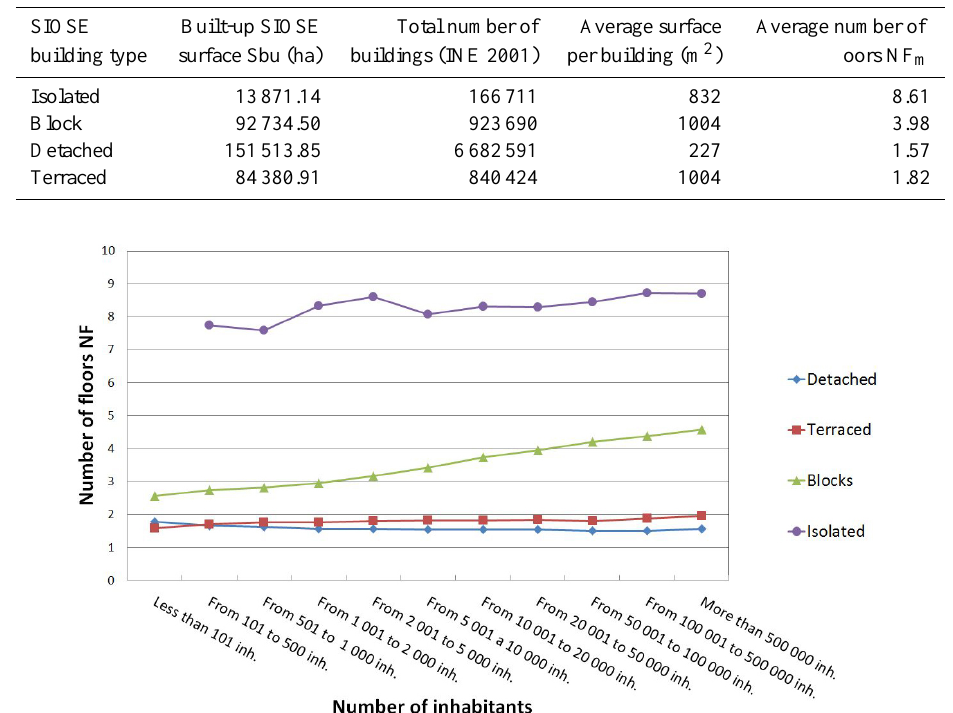
Figure 1. Variation in number of floors per type of building and municipality size.